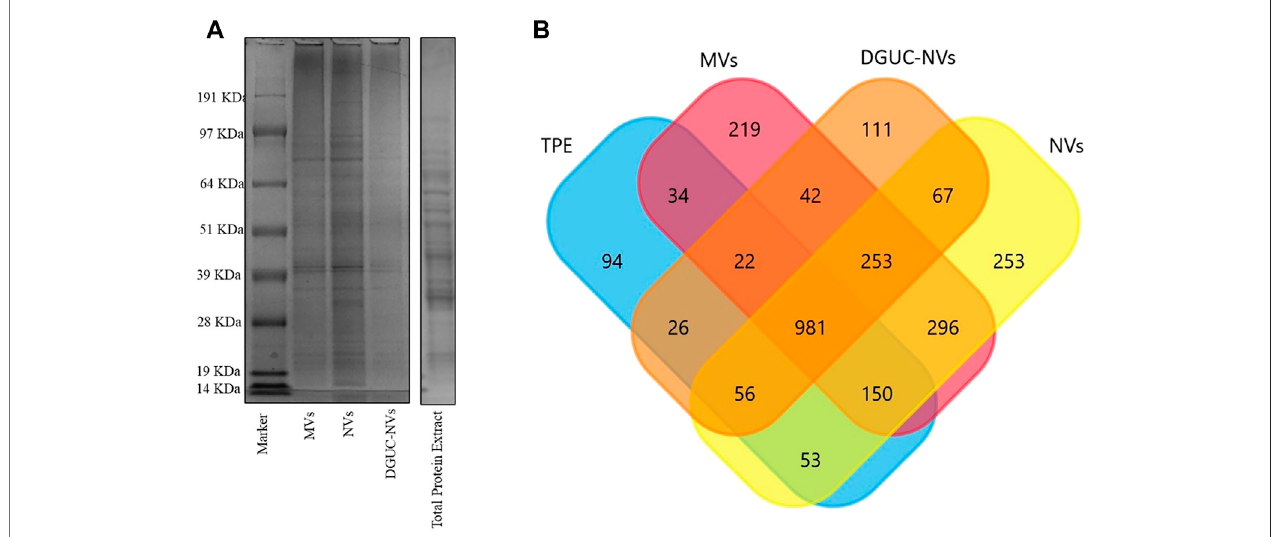
FIGURE2|(A) SDS-PAGEproteinpro fi leofMVs,NVs,DGUC-NVs,andtotalproteinextract(TPE). (B) Venndiagramshowingthenumberofidenti fi edproteinsand their overlappings in the TPE, MVs, crude NVs, and the sucrose gradient density DGUC-NV